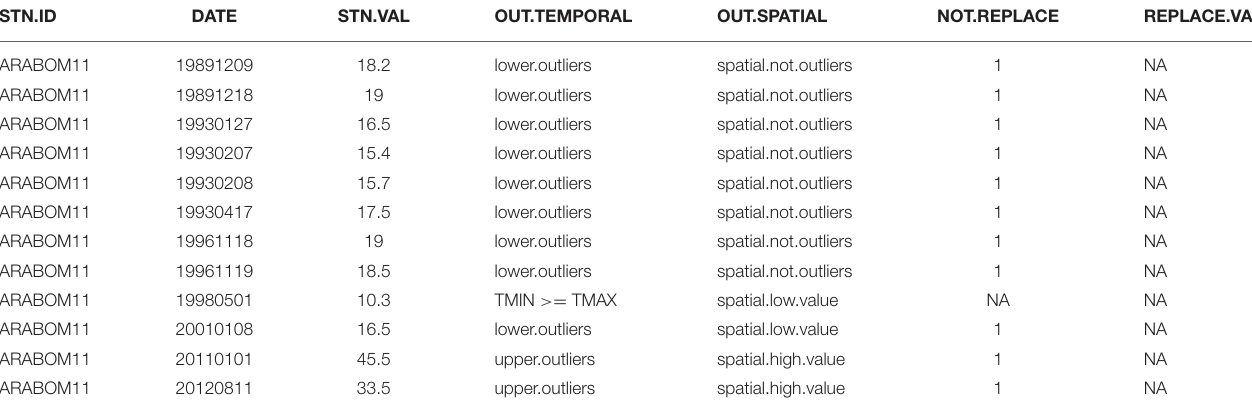
TABLE 2 | Number of reported data for each year and month for a given station.